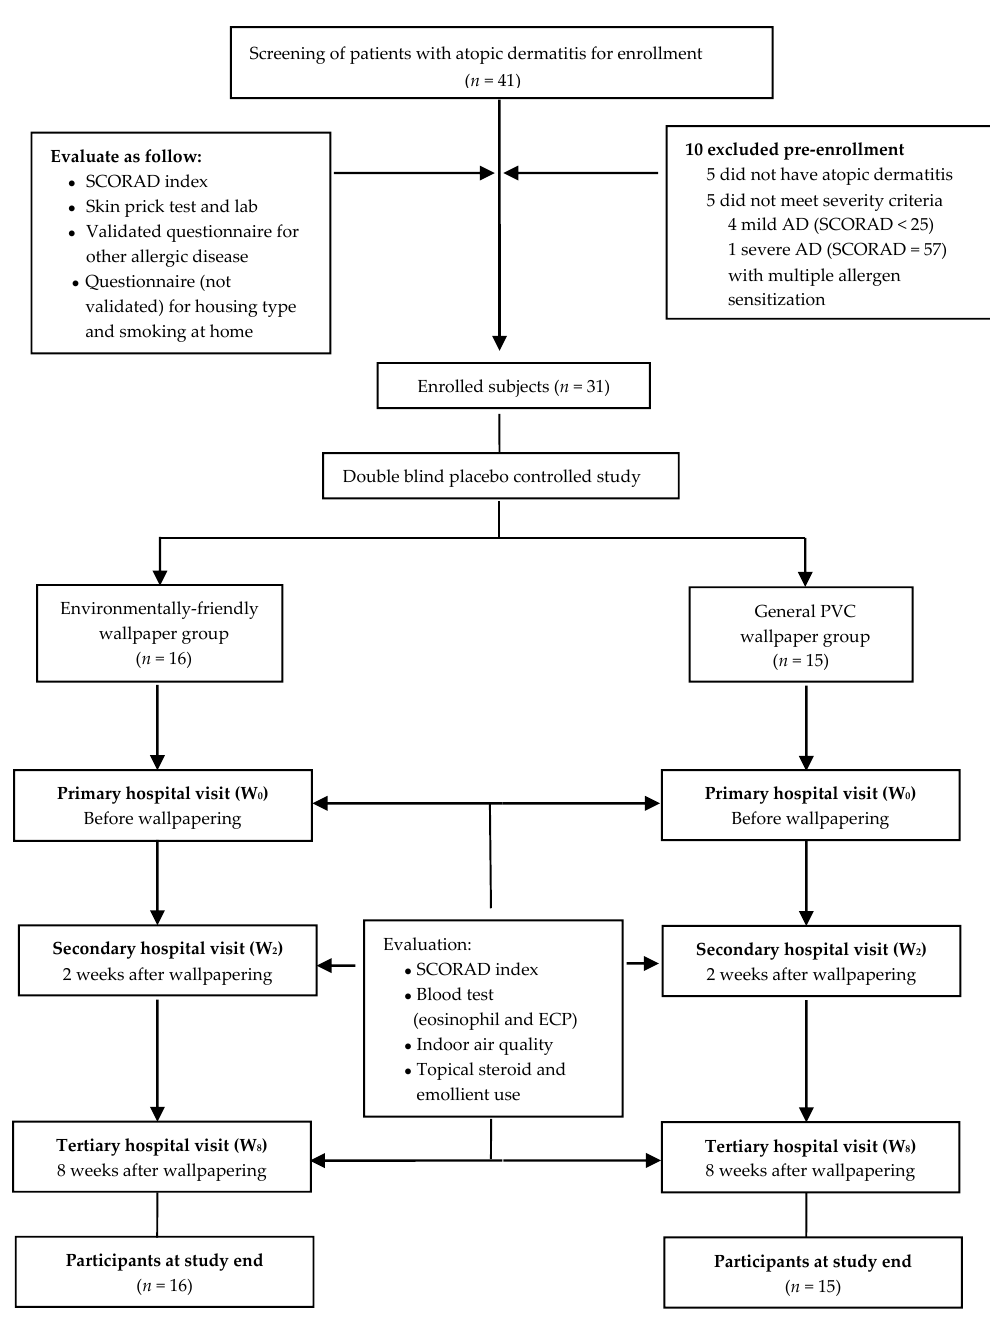
Figure 1. Study participants and design. AD: Atopic dermatitis; SCORAD: Scoring Atopic Dermatitis; PVC: Polyvinyl chloride; ECP: Eosinophil cationic protein.